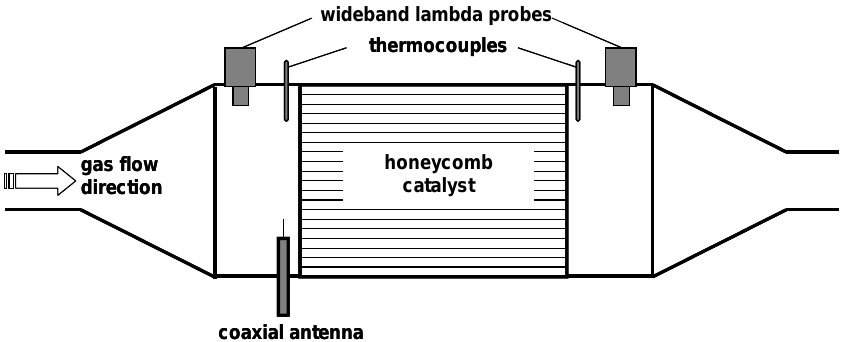
Figure 6. Schematic test setup for verifying the principle of the radio frequency-based catalyst status detection